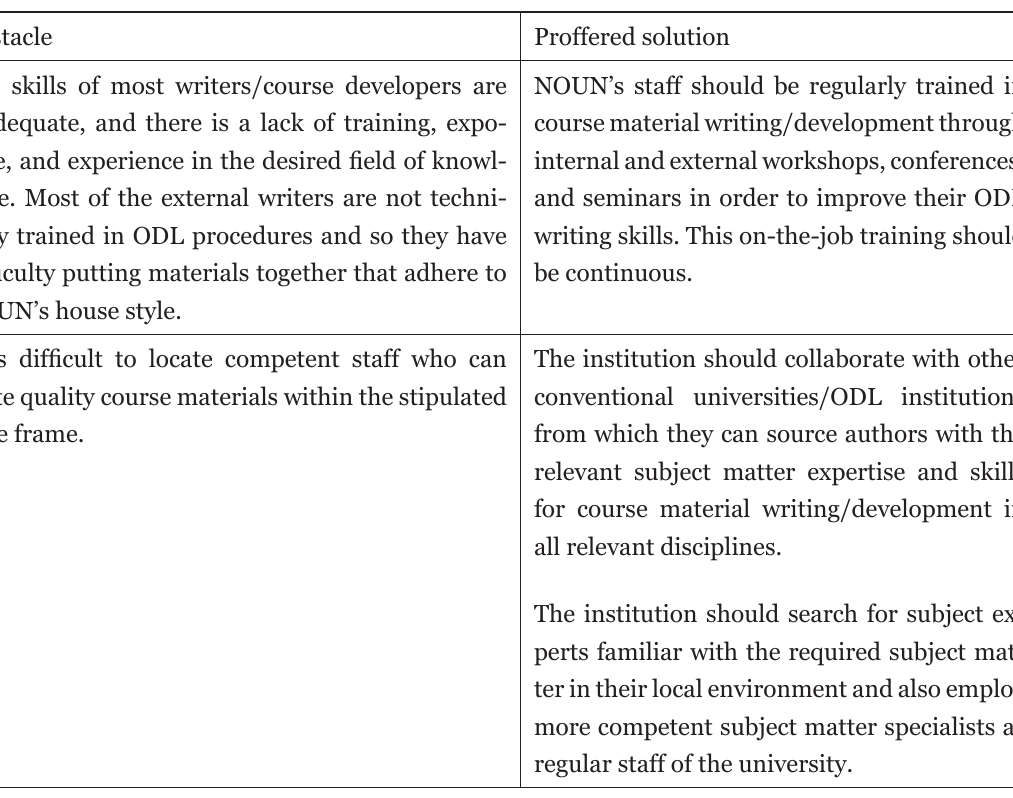
Obstacles Related to the Skills of Course Material